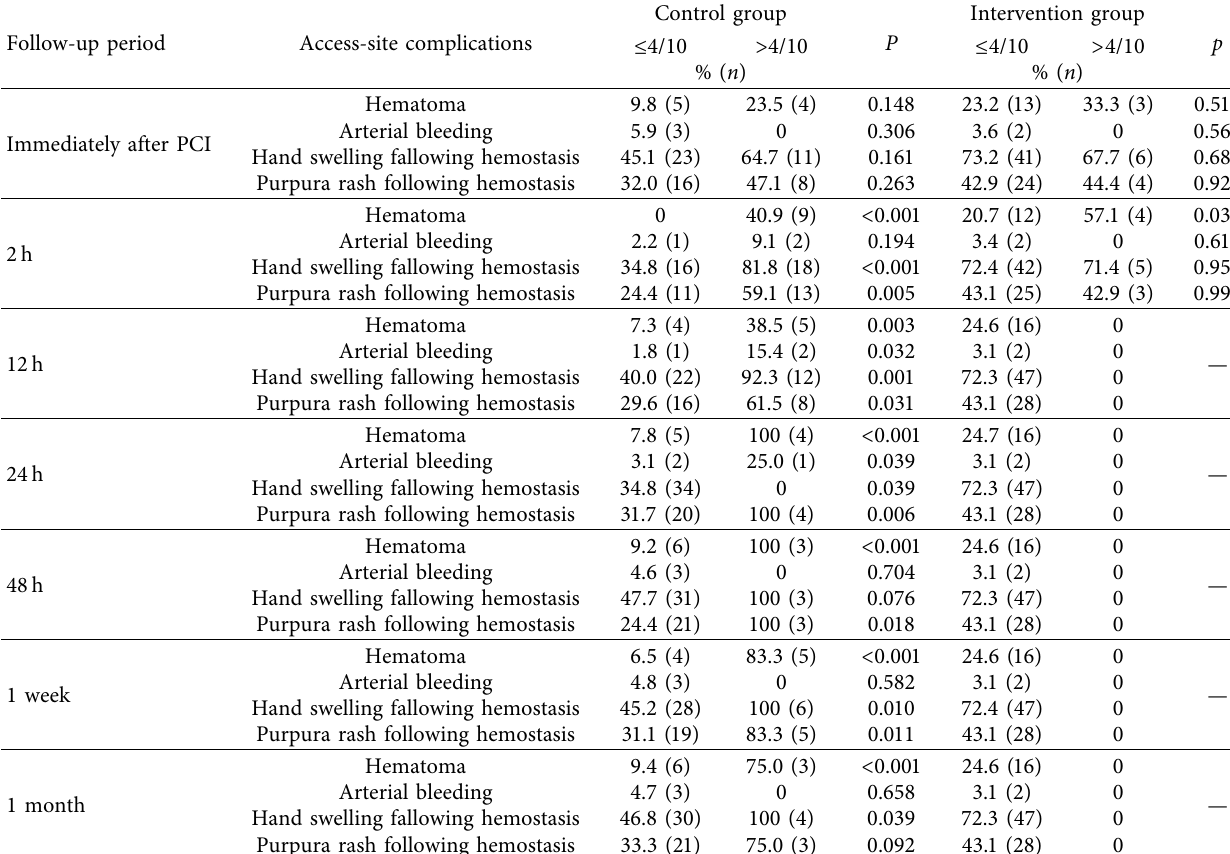
Table 4: Distributions of the accesses-site complications after PCI according to pain intensity subgroups ( ≤ 4/10 and > 4/10) during the follow-up period between intervention and control groups. Follow-up